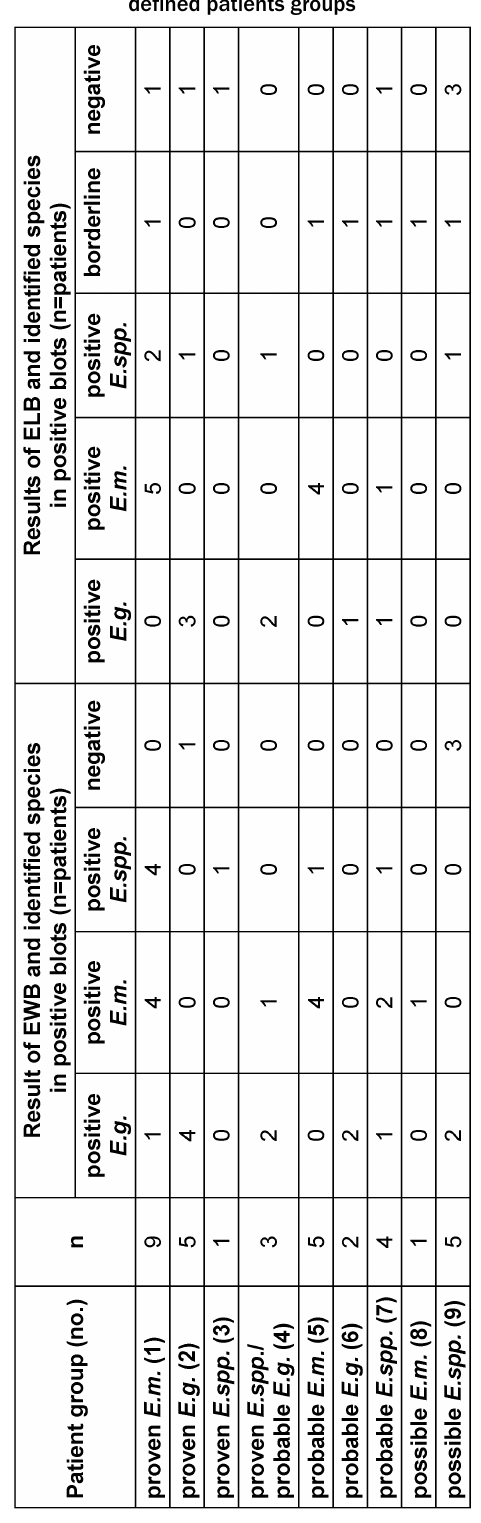
Table 2: Results of blots EWB and ELB with respect to the defined patients